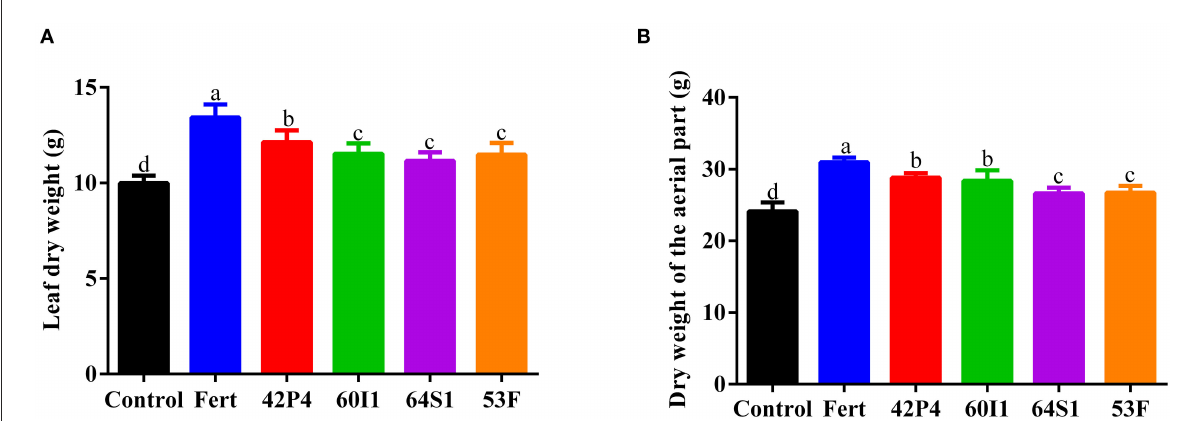
FIGURE1 (A) Dry weight of the leaves and (B) dry weight of the aerial parts (leaves and stems) of pepper plants of 110 day-old grown in pots and treated with: Fert: Fertilized; 42P4: Pseudomonas 42P4; 60I1: Cellulosimicrobium 60I1; 64S1: Enterobacter 64S1; 53F: Ochrobactrum 53F and